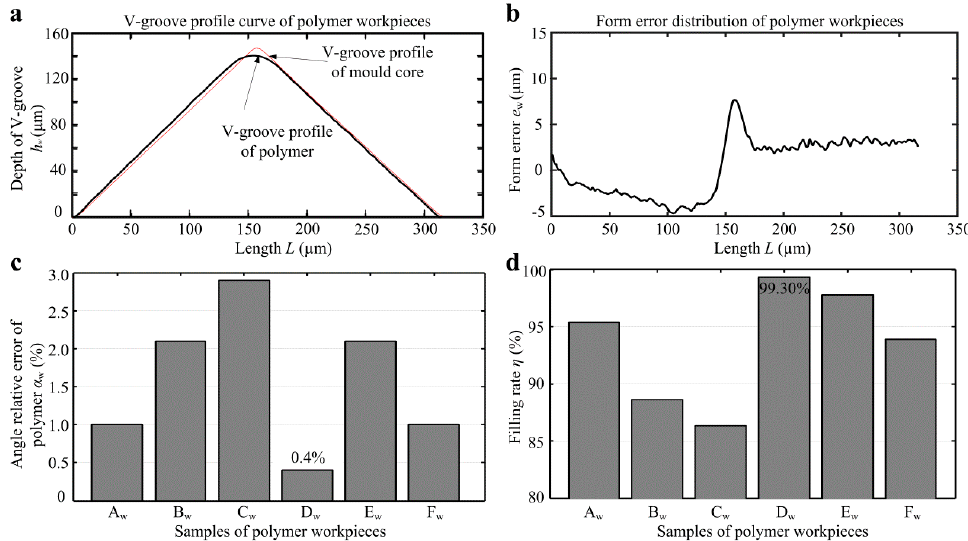
Figure 10. The angle relative error α w and filling rate η of micro-structured polymer: ( a ) V-groove profile curves of polymer D w and mold core D m ; ( b ) form error distribution of polymer D w ; ( c ) angle relative errors α w ; ( d ) filling rates η .